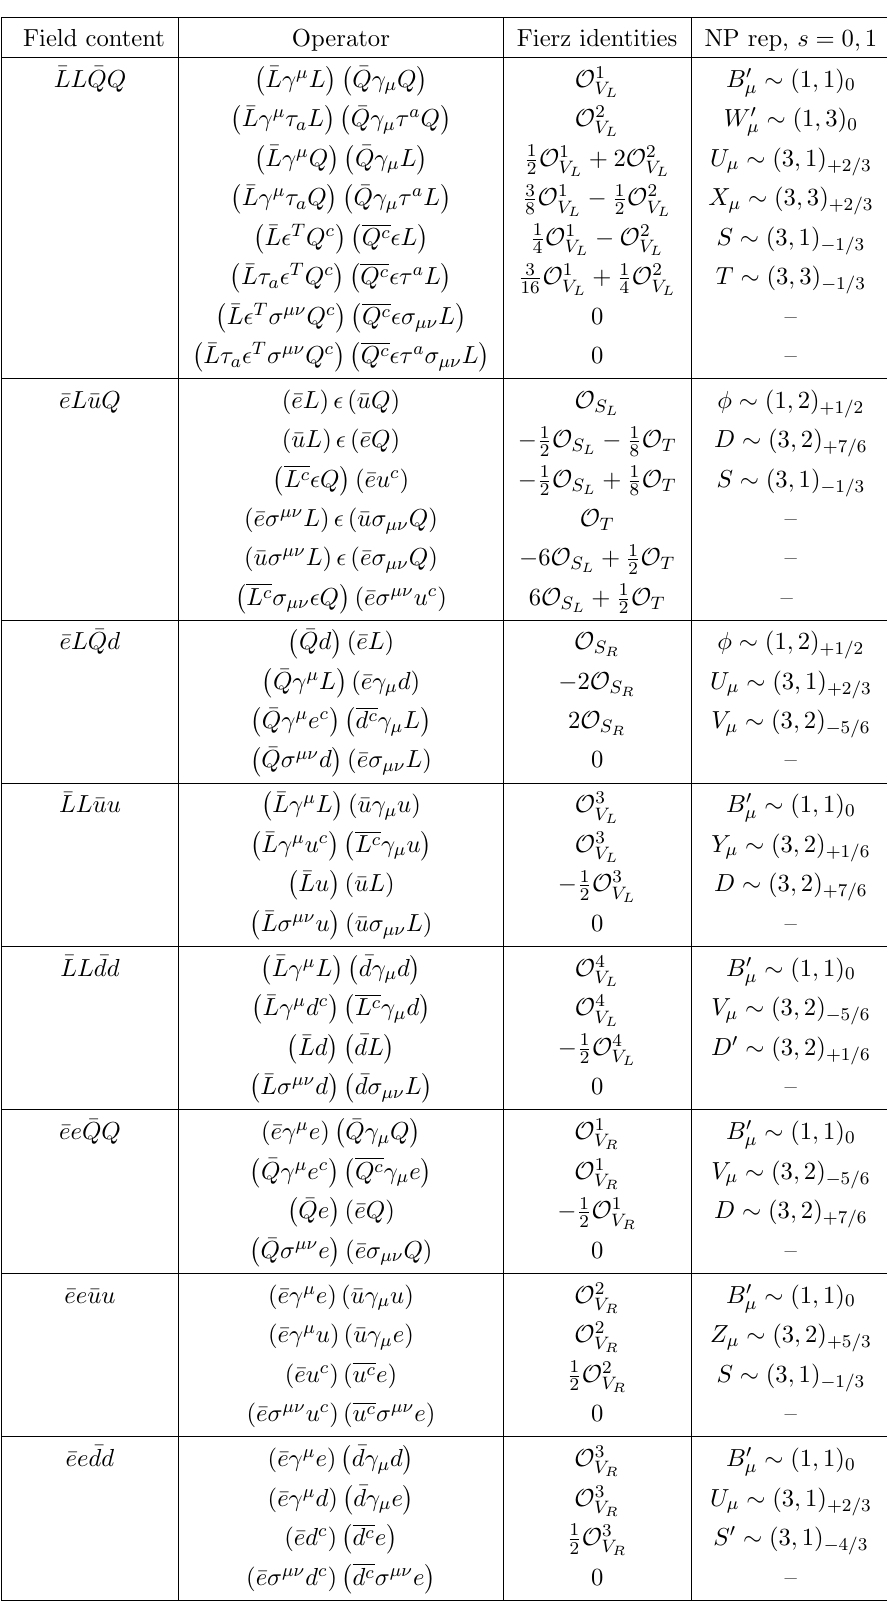
Table 2. Dimension six four-fermion